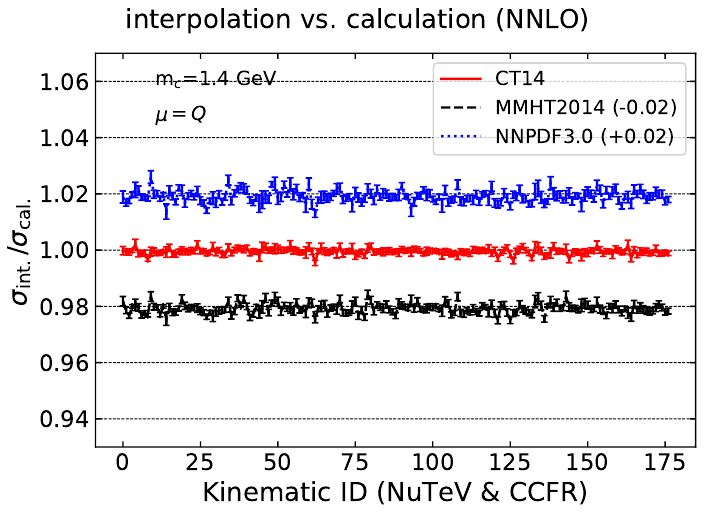
Figure 8 . Ratios of the interpolated NNLO cross sections and cross sections from direct calcu- lations using CT14, MMHT2014 and NNPDF3.0 PDFs all with the grid generated from the same run of CT14